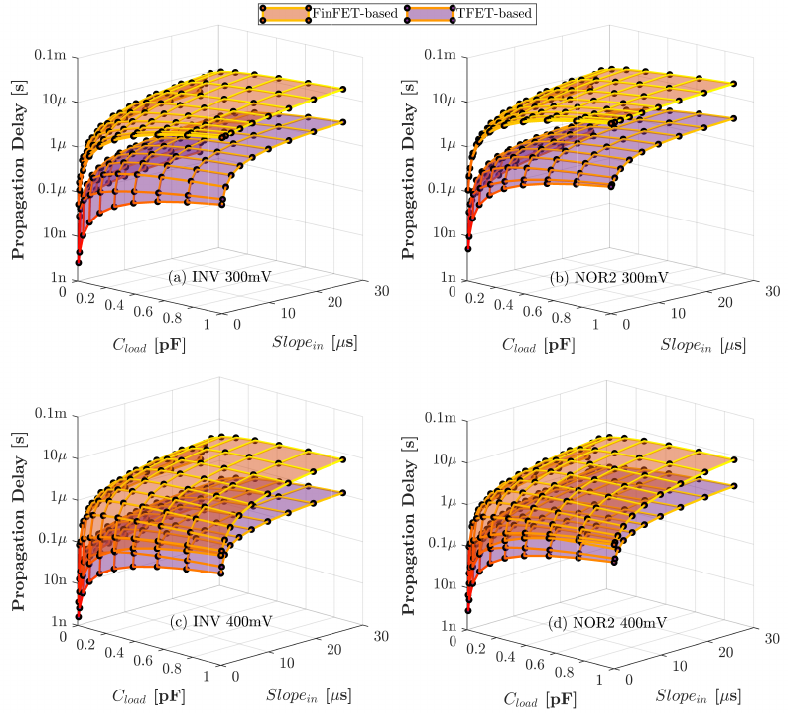
Figure 7. Propagation delay for TFET and FinFET-based INV, and NOR2 at supply voltages of ( a , b ) 300 mV and ( c , d ) 400 mV over a wide range of input transition slope and load capacitance